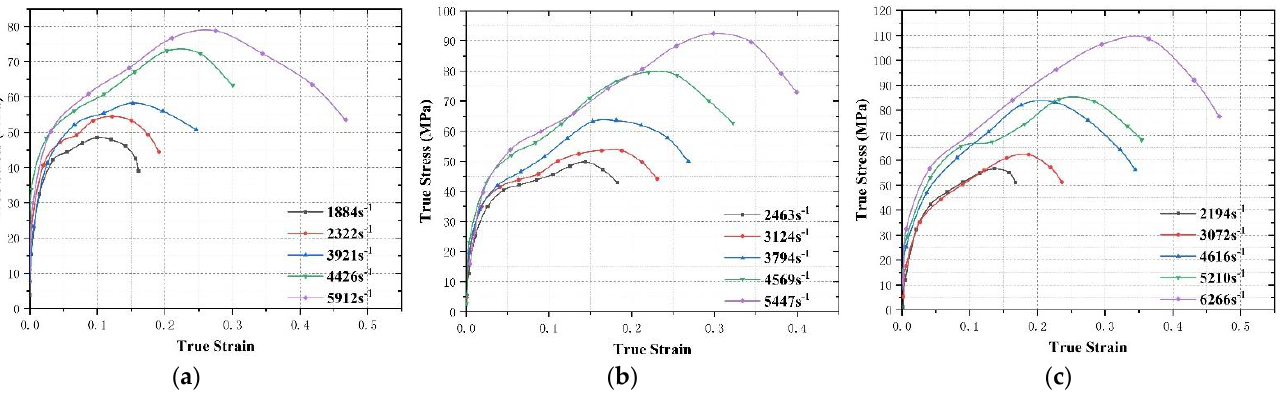
Figure 6. True stress – strain curves of PTFE/Cu with different densities under different strain rates: